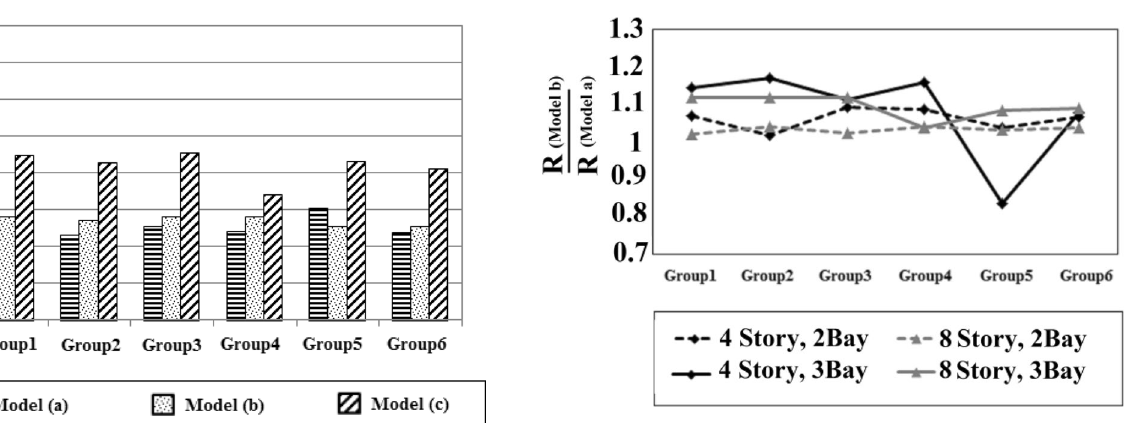
Fig. 16 Comparison of the response modification factors of the studied models of the 4-story 3-span structure